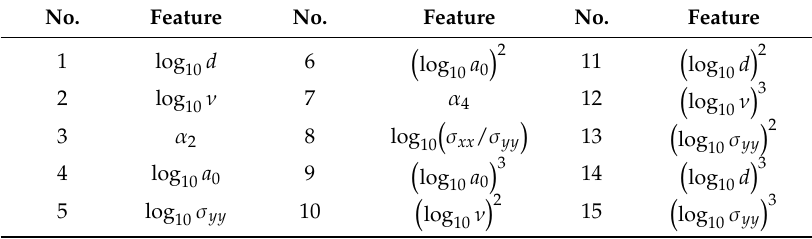
Table 3. Extracted features for insect mass estimation based on support vector regression (SVR). Note: the features were ranked based on the feature importance in estimating insect mass.